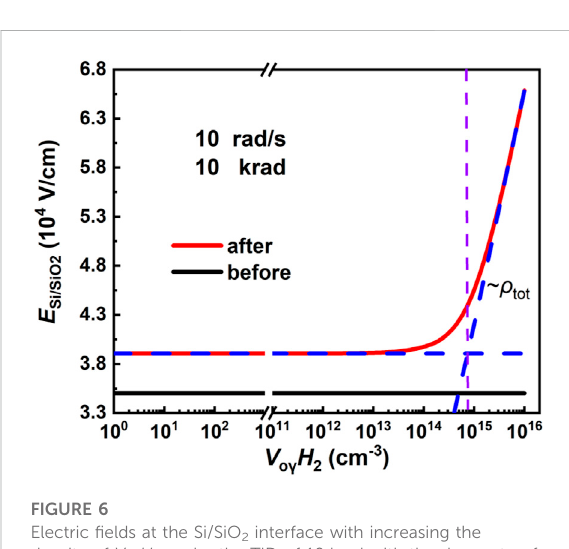
FIGURE 6 Electric fi elds at the Si/SiO 2 interface with increasing the density of V o γ H 2 under the TID of 10 krad with the dose rate of 10 rad/s at 300